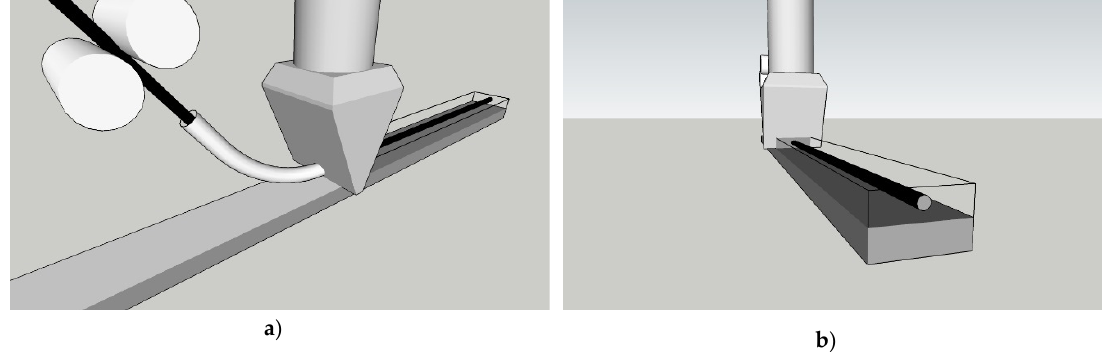
Figure 5. Integrating MCF into concrete filament: a ) supply of MCF yarn to the nozzle, and b ) cross- section of the printed layer with incorporated MCF